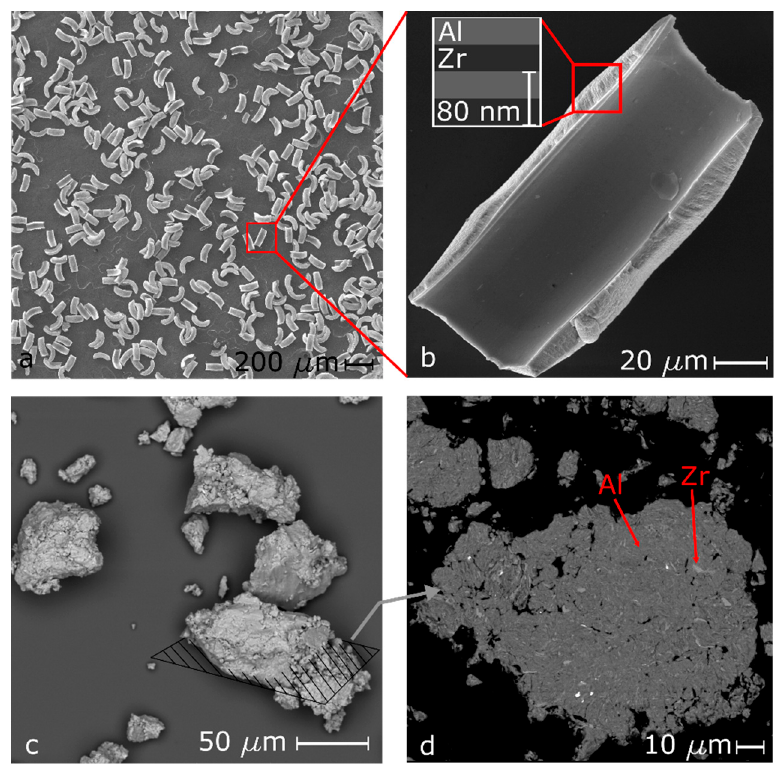
Figure 1. ( a ) Crescent-shaped Al:Zr physical vapor deposition (PVD) particles with lengths approximately equal to three times their widths. The particles are uniform in geometry for a given mesh size. ( b ) A single Al:Zr PVD particle. A schematic of the bilayer structure of each particle is shown within the inset. ( c ) Several ball milled Al:Zr particles exhibiting a rough and granular morphology with lines representing a cross-sectional slice, an example of which is shown in part ( d ). ( d ) A representative cross-section of an Al:Zr particle taken via backscatter scanning electron microscope (SEM), exhibiting Zr inclusions within an Al matrix.